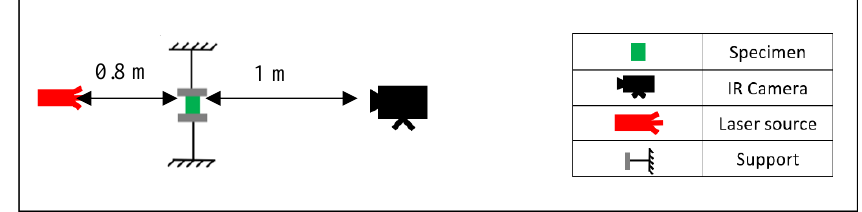
Figure 7. Schematic experimental configuration.